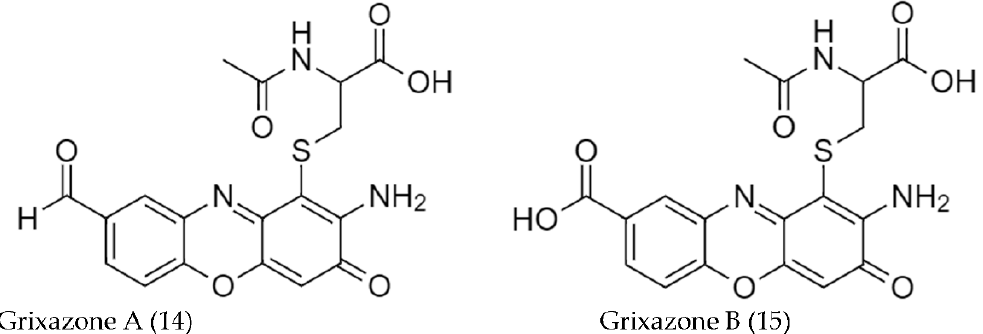
Figure 10. Chemical structures of grixazones.